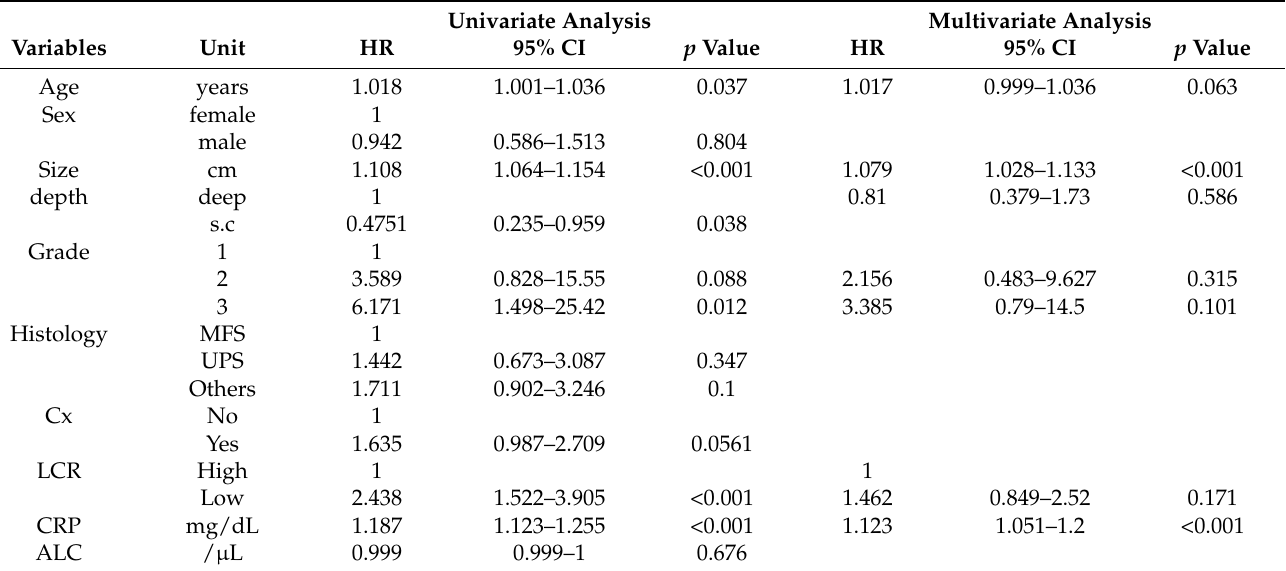
Figure 2. Kaplan–Meier curves showing event-free survival. A: Patients with a higher lymphocyte- to-C-reactive protein ratio; B: Patients with a lower lymphocyte-to-C-reactive protein ratio. Table 4. Univariate and multivariate event-free survival